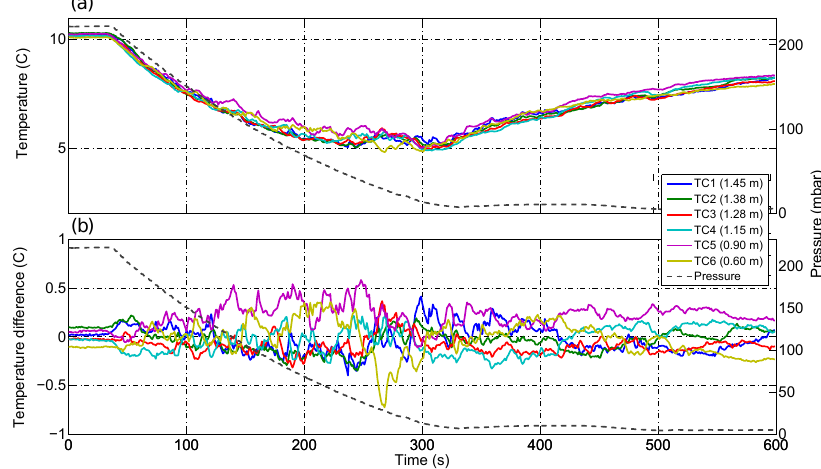
Figure 1. (a) the evolution of temperature measured by the 6TC before, during and after an expansion. Pressure above atmospheric pressure is also shown (dashed line, right hand axis). (b) shows the deviation of the temperature measured by each individual TC from the mean of all TC.